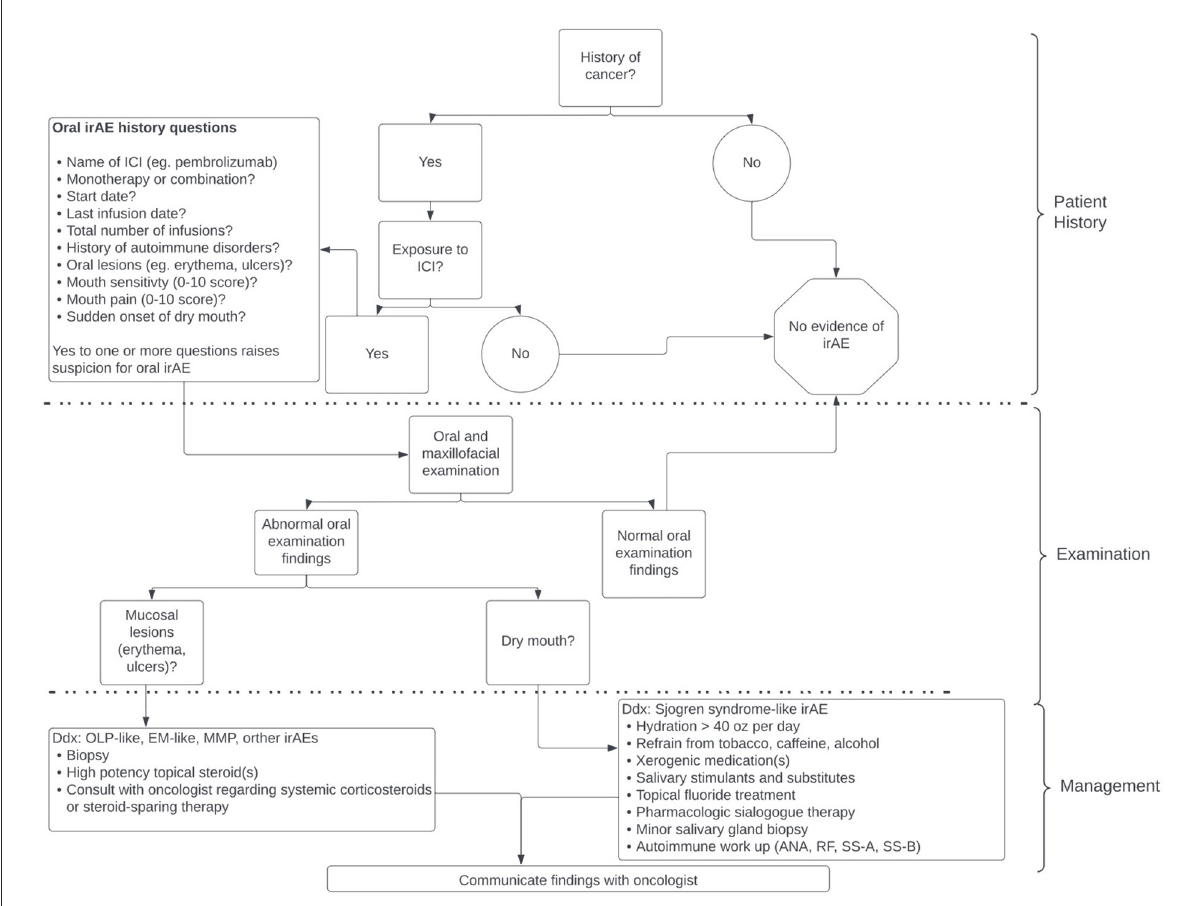
FIGURE1 Approach to identifying patients with immune-related adverse events (irAEs) and overview of